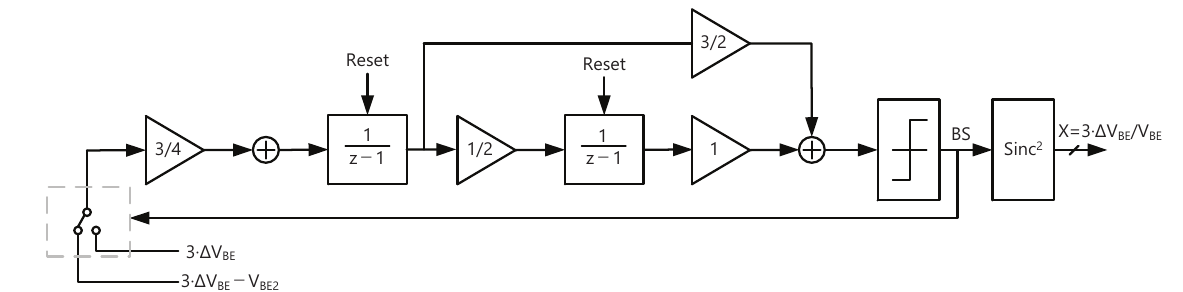
Figure 6. Block diagram of the incremental ∆ - Σ ADC.